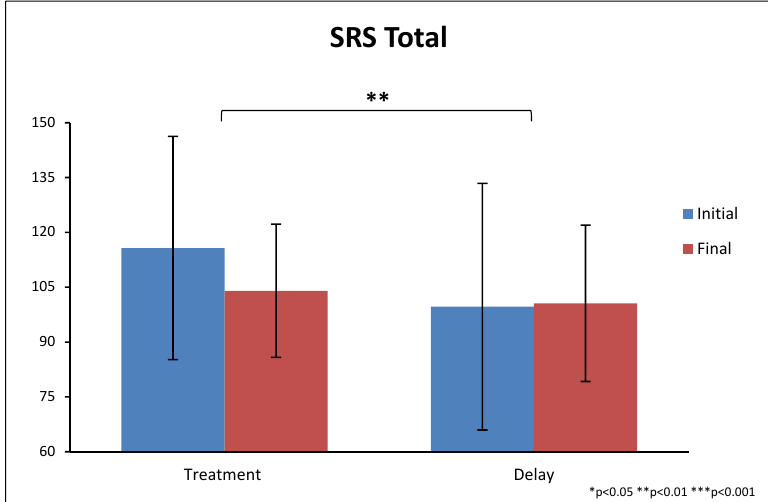
Figure 11. Total SRS scores at the beginning and end of the study. Higher scores indicate greater severity, and 54 is the cut ‐ off for an ASD diagnosis. Error bars represent standard deviations.